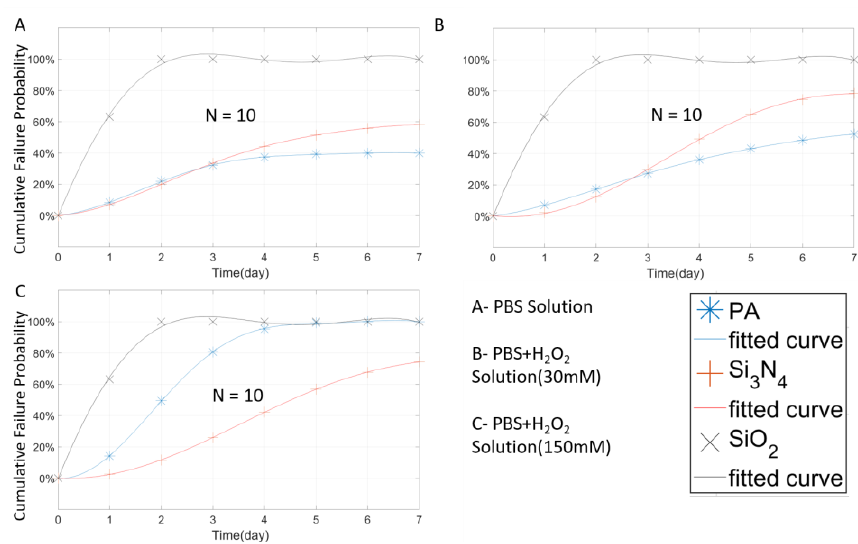
Figure 8. The Weibull cumulative distribution data and corresponding curve fitting of the closed-tip tungsten wires with a single layer coating (1 µm) of PA, Si 3 N 4 , and SiO 2 , tested at 67 °C in different solutions.